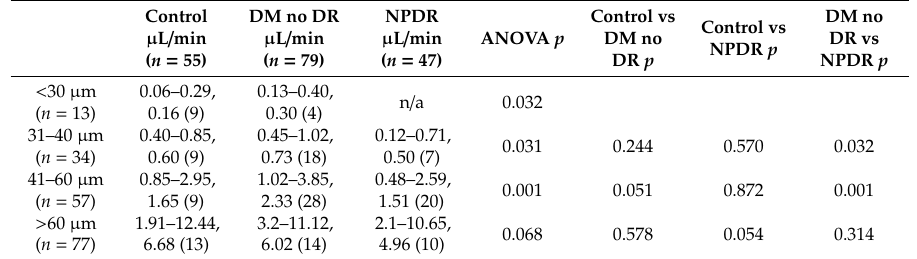
Table 6. Summary of arteriolar blood flow by vessel diameter groups, comparing healthy controls, diabetes without retinopathy, and non-proliferative diabetic